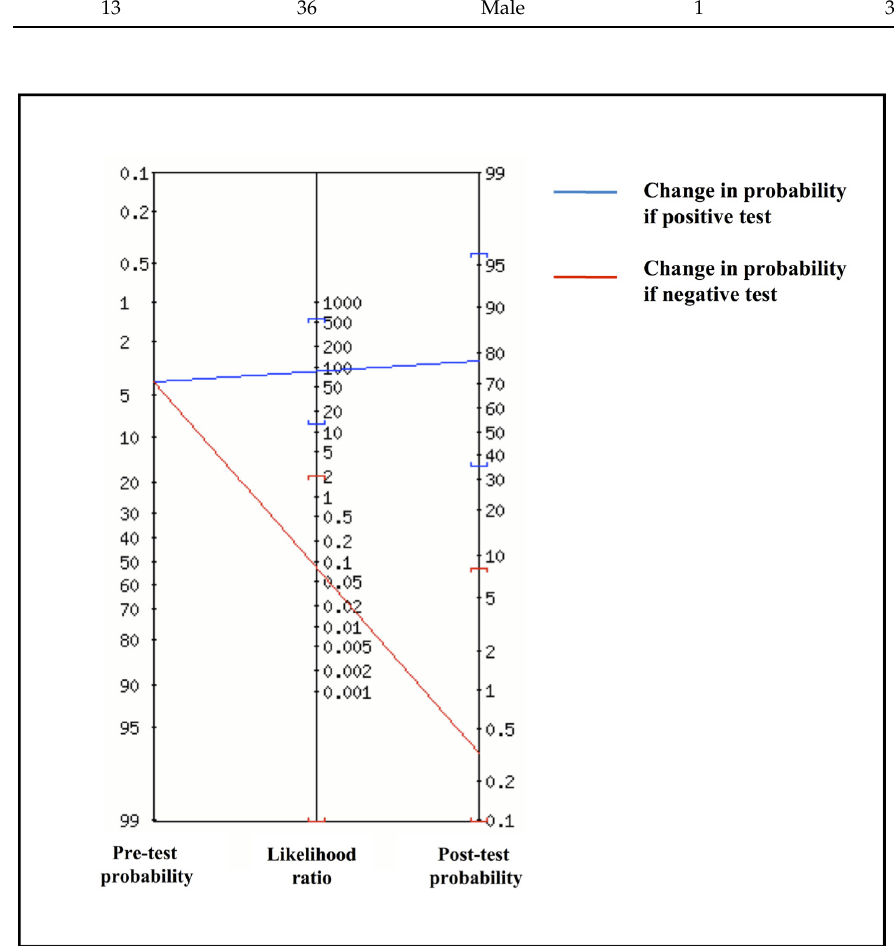
Figure 2. Fagan’s nomogram from positive (PLR) and negative likelihood ratio (NLR).